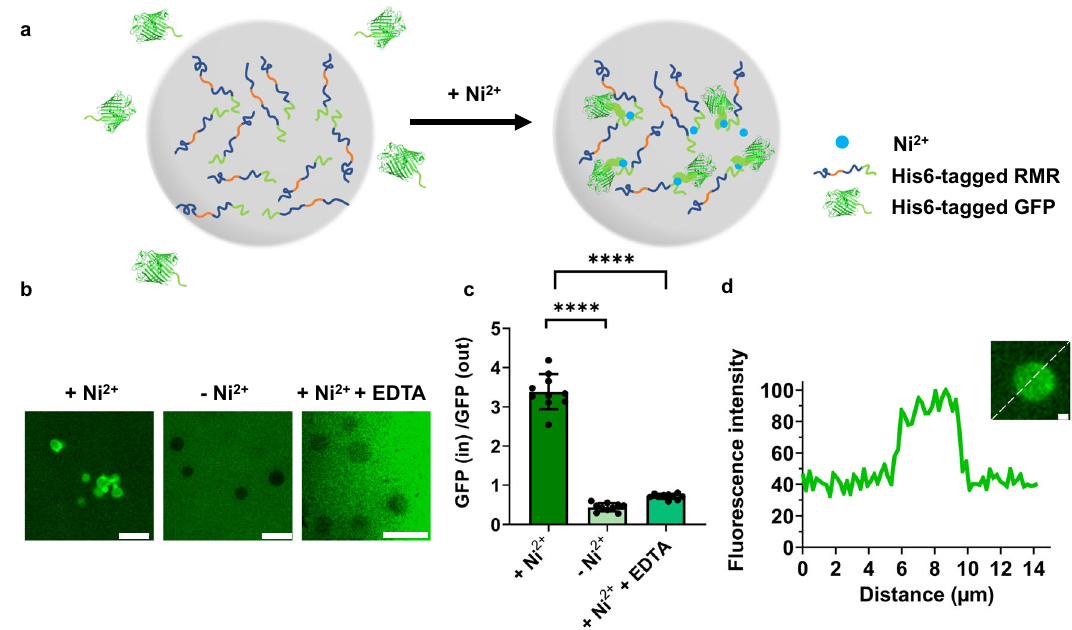
Fig. 6 Decoration of RMR condensates with His6-tagged GFP via metal coordination. a Schematic illustration of Ni 2 + -induced recruitment of His6- tagged GFP into RMR condensates. b Fluorescence micrographs showing GFP-deprived and GFP-laden RMR condensates in the absence and presence of Ni 2 + (50 μ M), as well as those in the presence of Ni 2 + (50 μ M) and excess of EDTA (2 mM). Scale bars: 10 μ m. Images representative of n = 3. c Relative distribution of GFP inside and outside RMR condensates. Enrichment ef fi ciency was calculated using the equation, Enrichment ¼ GFP ð in Þ = GFP ð out Þ . Data are presented as mean ± SD ( n = 10); two-side t -test, p -value: **** < 0.0001 [ p = 2.75 × 10 − 8 ( + Ni 2 + vs - Ni 2 + ); p = 3.19 × 10 − 5 ( + Ni 2 + vs. + Ni 2 + + EDTA)]. d Representative micrograph of a GFP-laden condensate and its normalized fl uorescence intensity pro fi le. Scale bar: 1 μ